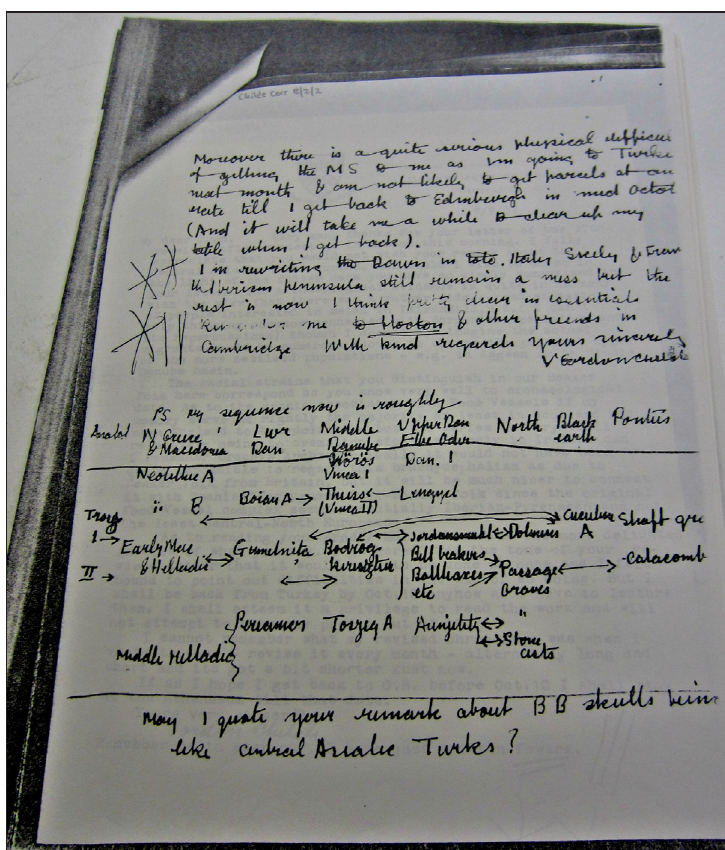
Figure 2: Letter from Childe to American anthropologist Carleton Coon, with a rough draft of his chronological tables for the third edition of The Dawn . 1937. (Photo UCL Institute of